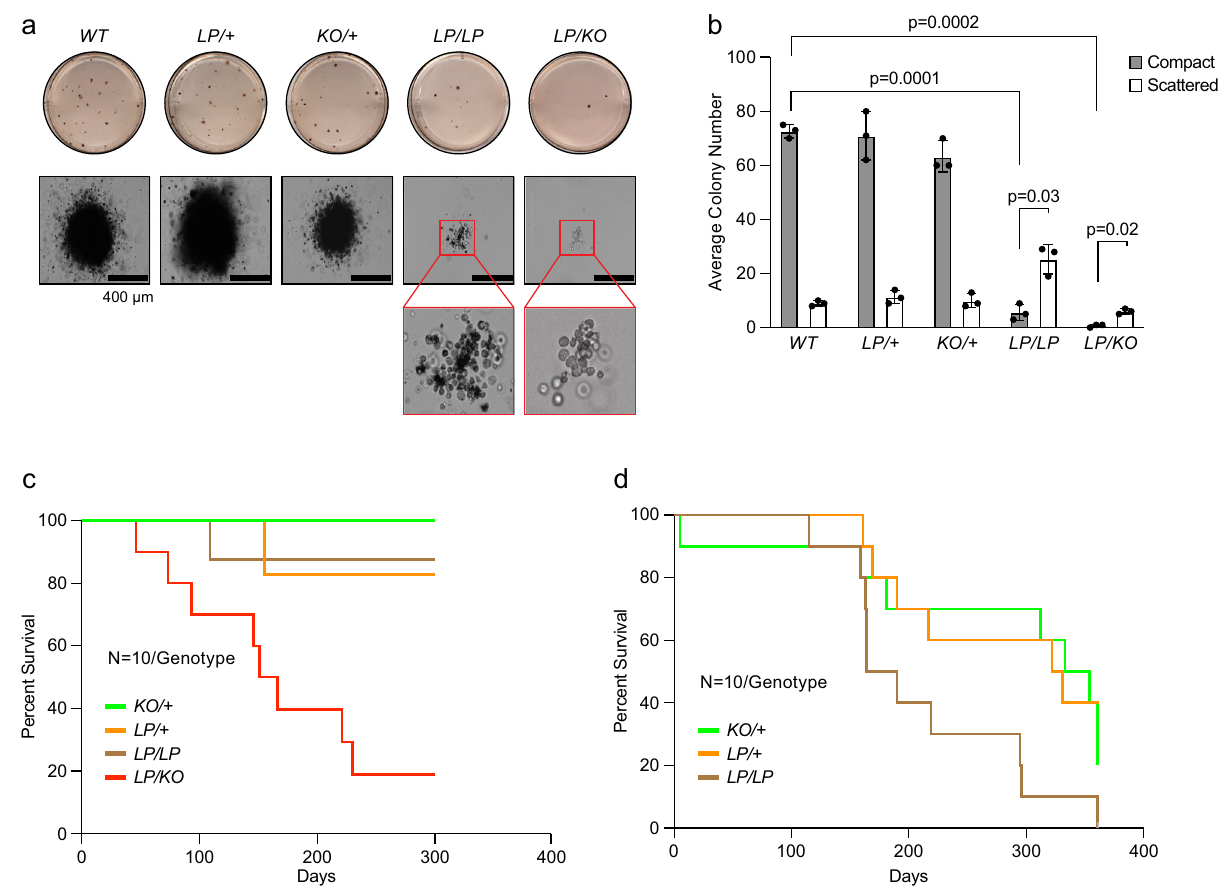
Fig. 2 Functional characterization of hematopoietic progenitor cells from fetal liver. a Colony-forming assay to examine proliferative potential of hematopoietic progenitors from fetal liver isolated from 16.5dpc embryos of different genotypes. LP/LP and LP/KO showed reduced number of compact colonies. Inset shows morphology of scattered colonies. b Quanti fi cation of colony numbers for indicated genotype shows reduced number of compact LP/LP and LP/KO colonies and higher number of scattered LP/LP and LP/KO colonies ( n = 3 biological replicate, two-tailed Students t-Test, error bar- SD of mean). c Kaplan – Meier survival curve of lethally radiated recipient mice after bone marrow reconstitution by fetal liver cells of indicated genotypes. LP/KO fetal liver cells show reduced bone marrow reconstitution leading to shorter median survival of the recipients ( n = 10, p = 0.0003, Log-rank Mantel – Cox test). All other genotypes showed no signi fi cant difference in survival. d Kaplan – Meier survival curve of lethally radiated recipient mice after secondary transplantation using bone marrow from primary transplantation recipients. LP/LP bone marrow reconstitution shows signi fi cantly reduced median survival as compared to WT ( n = 10, p = 0.041, Log-rank Mantel-Cox